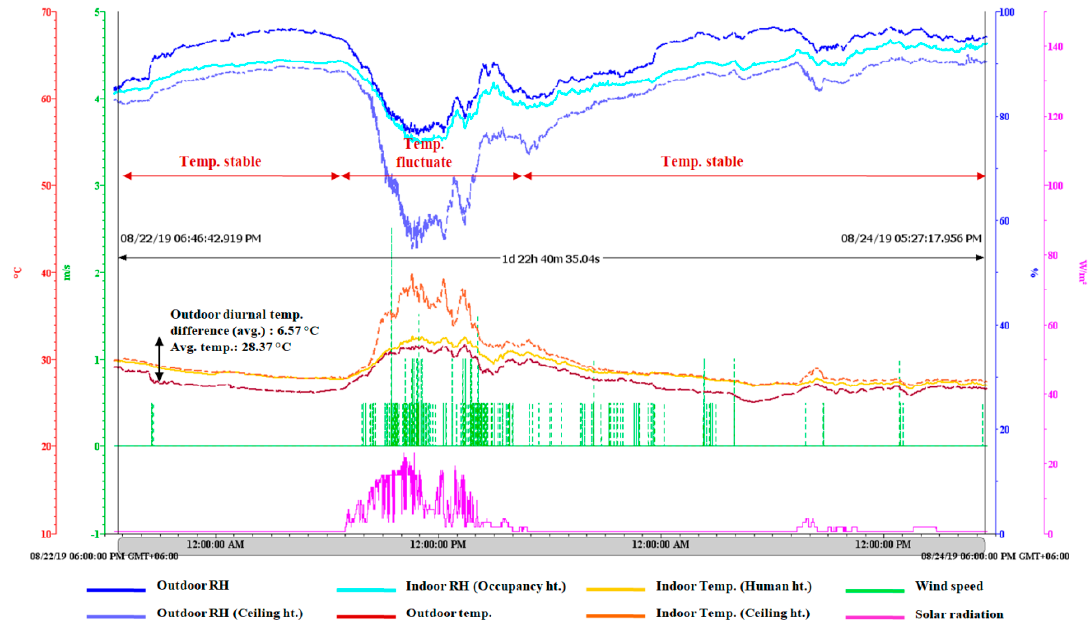
Figure 10. Indoor thermal performance of H-3 (Source: Field data from HOBO weather station).